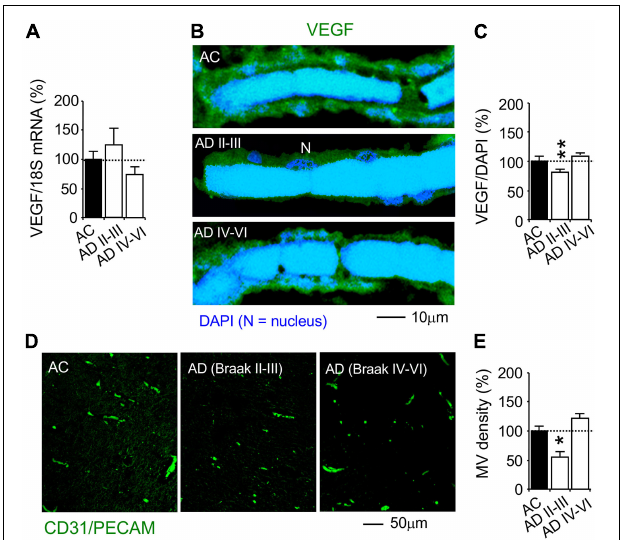
FIGURE 8 | Reduction of VEGF protein, but not mRNA, expression and microvascular loss in the CA1 stratum radiatum of autopsy-confirmed AD human hippocampus. (A) Quantitative PCR (qPCR) was used to detect VEGF mRNA at the whole hippocampus level. (B,C) Immunohistochemistry and confocal microscopy were used to determine VEGF protein expression in MV wall cells in hippocampal CA1 area (N, the nucleus of MV wall cell). (D,E) Immunofluorescence of the vascular endothelial cell marker CD31/PECAM was used to determine MV density. AC, age-matched control; AD, autopsy-confirmed Alzheimer’s disease. Although VEGF mRNA was not different among the experiment groups, VEGF and MV density was decreased in AD hippocampi at the early Braak stages II–III, but not AD at the late Braak stages IV–VI, compared to AC group. Data are reported as mean ± SEM, * p < 0.05; ** p < 0.01; two-tailed t -test compared with their according controls ( n = 11 hippocampi per group for qPCR or n = 182–365 random MV cells from 11 hippocampi per group, or 87–105 random CA1 areas from 5 AD Braak II–III, 14 AD Braak IV–VI and 19